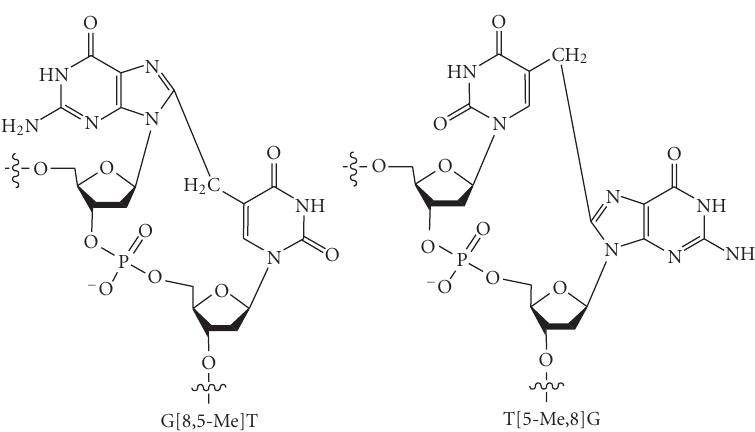
Figure 1: Chemical structures of the two γ -radiation-induced intrastrand cross-links, G[8,5-Me]T and T[5-Me,8]G.